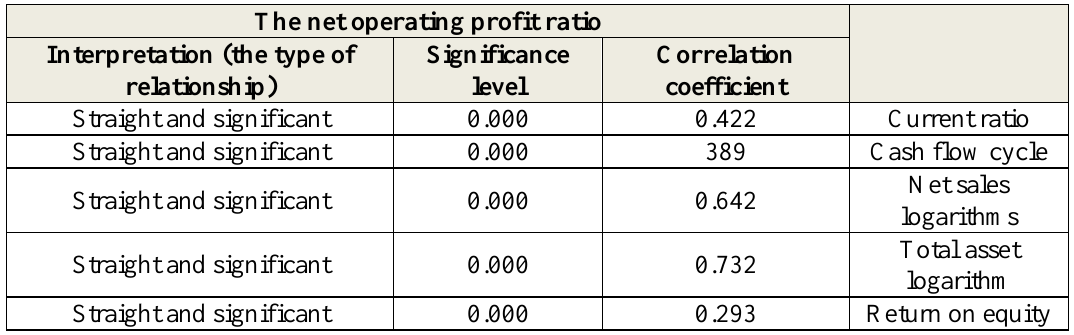
Table 4. Correlation Coefficient.